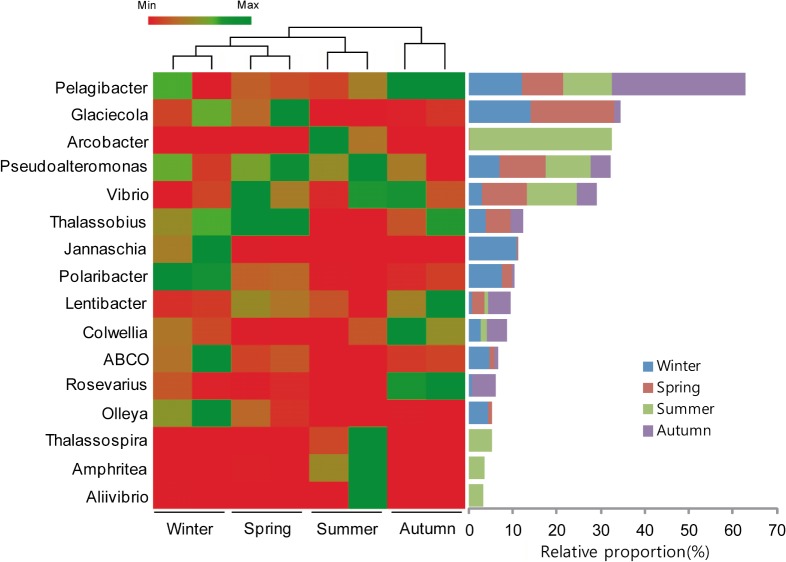
Heat map showing the relative abundances and distribution of representative 16S rRNA gene tag sequences classified at the genus level.Display with minimum ratio (5%) of the normalised abundance, using an RDP confidence level of 0.7. The normalised data were centred by the mean and clustered using the complete linkage method and a metric of correlation (uncentred). The colour code indicates differences in the relative abundance from the mean, ranging from red (negative) through black (the mean) to green (positive).